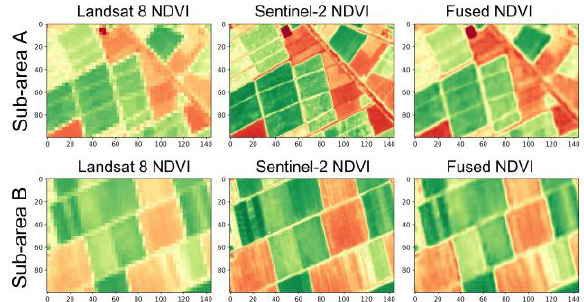
Figure 3. Visual comparisons between the actual and the predicted Sentinel-like NDVI with the corresponding Landsat NDVI on May 09, 2017. Note that the sub-areas A and B are selected and cropped from the study site In generally, it is observed that the proposed method produces accurate and satisfactory results regarding the fact that the actual and predicted images are comparable and exhibit spatial and spectral similarities.